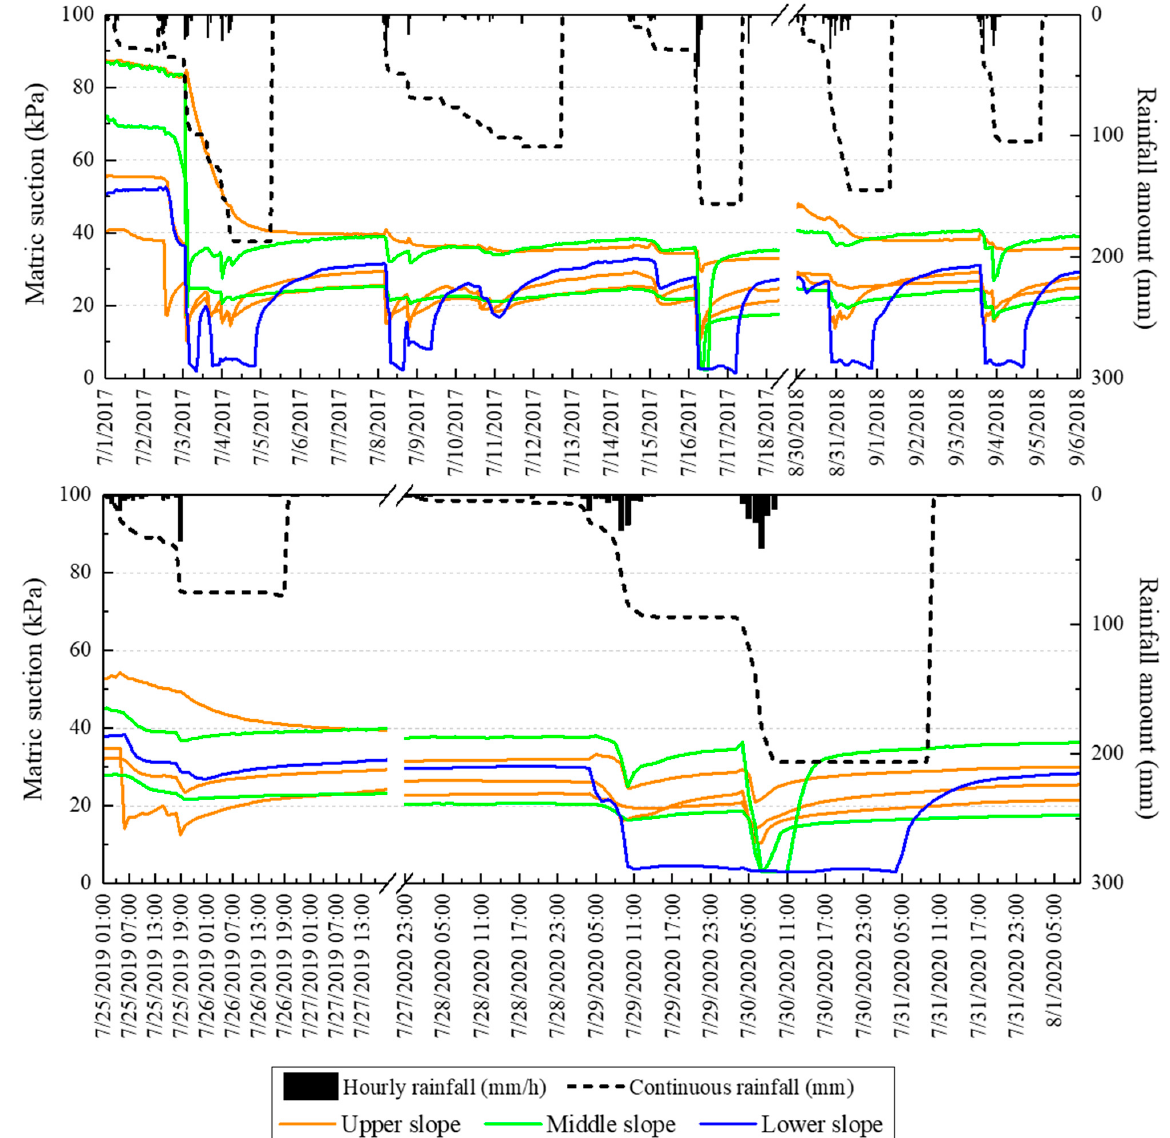
Figure 13. Comparison of continuous rainfall and matric suctions at 1.0 m in the slope of the Songnisan monitoring station during annually representative rainfall events in the four-year study period.